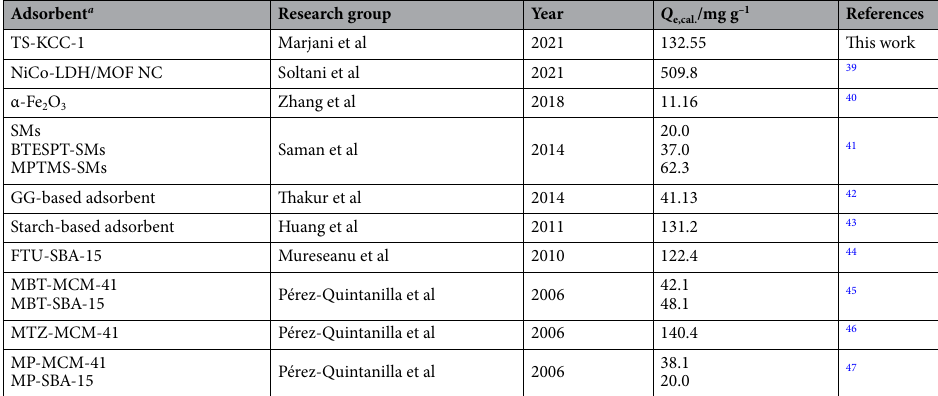
Table 3. The maximum adsorption capacities for Hg(II) reported in previous works. a